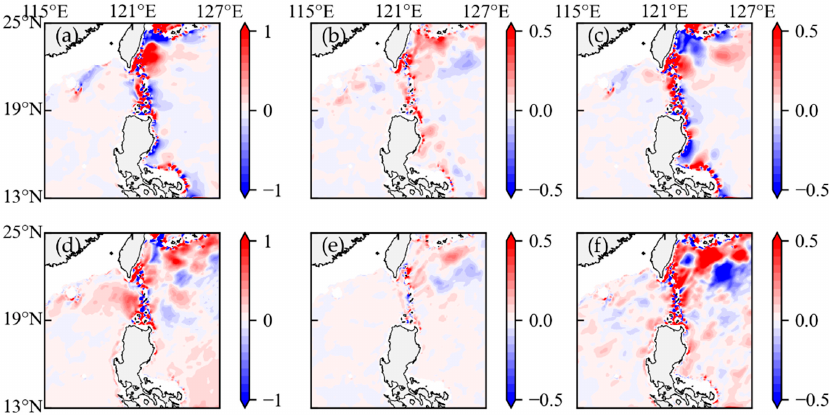
Figure 10. Temporally (1996–2015) and vertically (lower 266 m) averaged canonical transfers (10 − 5 Wm − 3 ). ( a ) Γ K 0 2 ; ( b ) Γ K 1 2 ; ( c ) Γ K 0 1 ; ( d ) Γ A 0 2 ; ( e ) Γ A 1 2 ; ( f ) Γ A 0 1 . To further explore the vertical structures of energy transfers, the sections of all sub- regions are shown in Figure 11. Corresponding to Figure 9a,d, the WPO subregion in east of Taiwan has a strong forward energy cascade (i.e., Γ K 0 2 > 0 and Γ A 0 2 > 0), but the mag- nitude of Γ K 0 2 is much larger than that of Γ A 0 2 (Figure 11a solid and dotted red lines). It indicates that the energy transfer between climatological and eddy is dominated by ki- netic energy cascade. This high intensity kinetic energy cascade continues even near the 400 m layer, which is the deepest of all regions. The situation that kinetic energy cascade exceeds potential energy cascade also exists in the Luzon Strait (LS). Through the solid purple line in Figure 11a, we also find that the inverse kinetic energy cascade in the LUZ subregion (Figure 9a) roughly occupies in the range from 50 to 150 m layers.